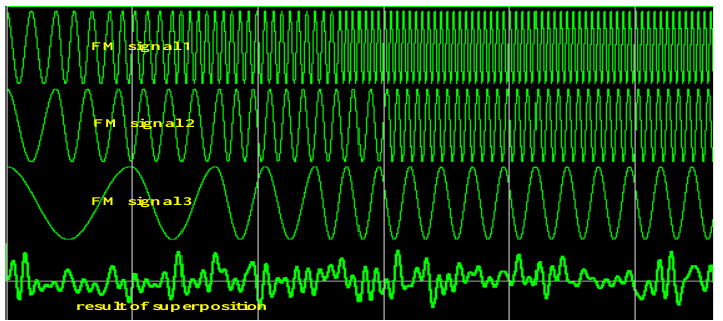
Figure 6. Hardware simulation of channel fading